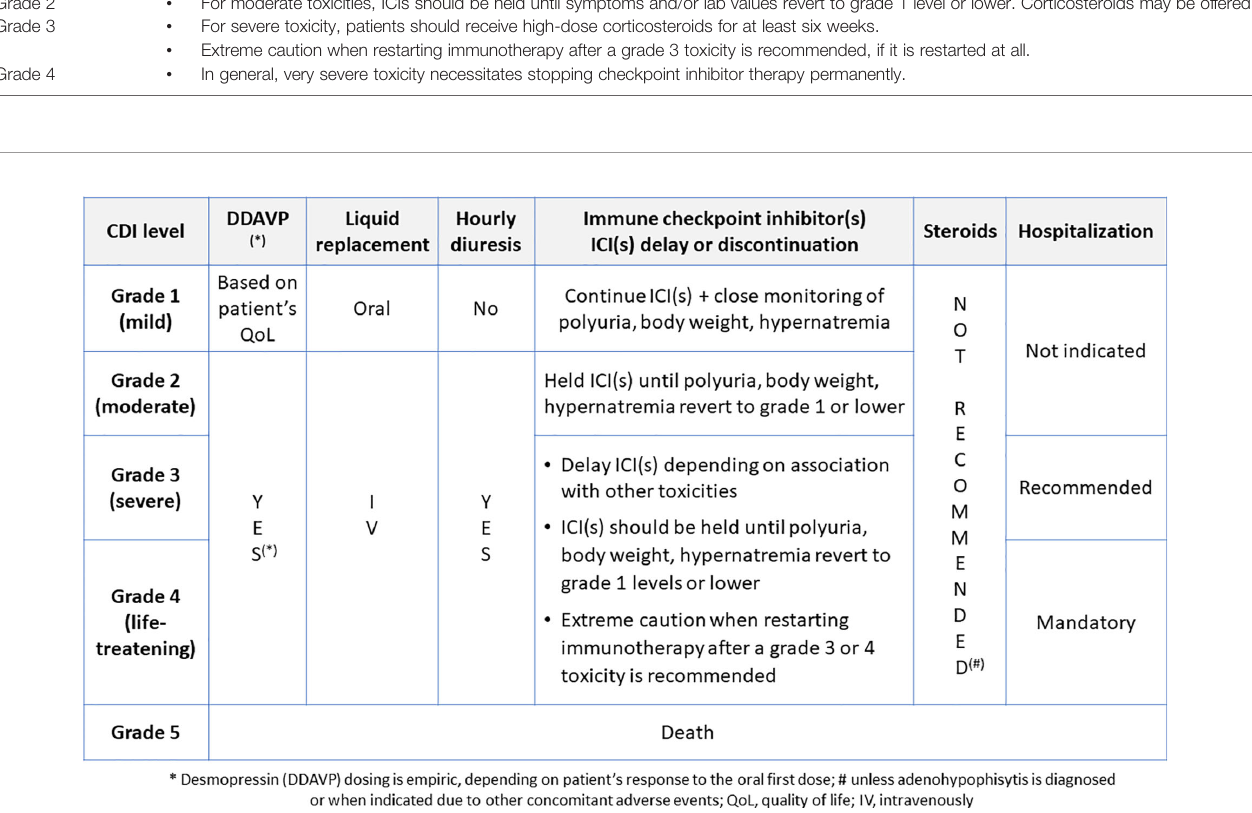
FIGURE 2 | The suggested management of desmopressin and ICI(s) in patients with ICI-CDI.